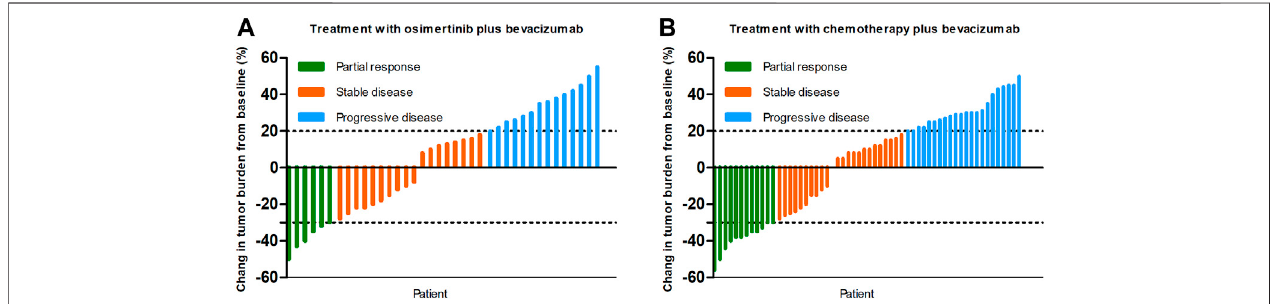
FIGURE 2 | Best response in tumor burden from baseline in the two